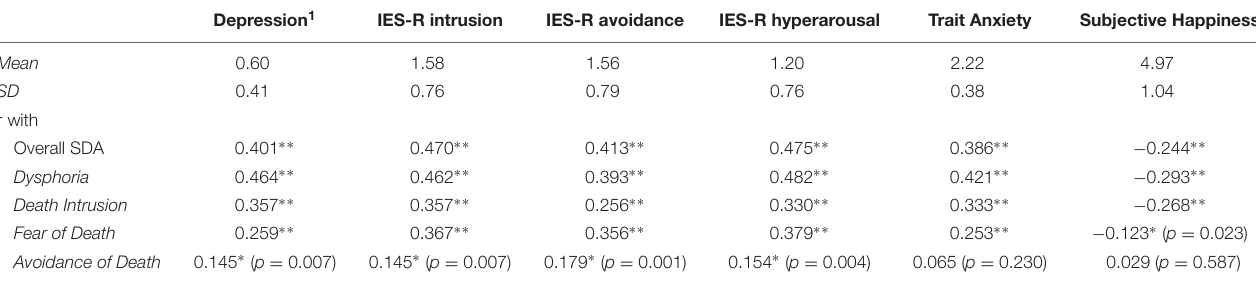
TABLE 3 | Means, standardized deviation (SD) of measures, and correlations between overall of SDA, four dimensions of SDA and other measures.